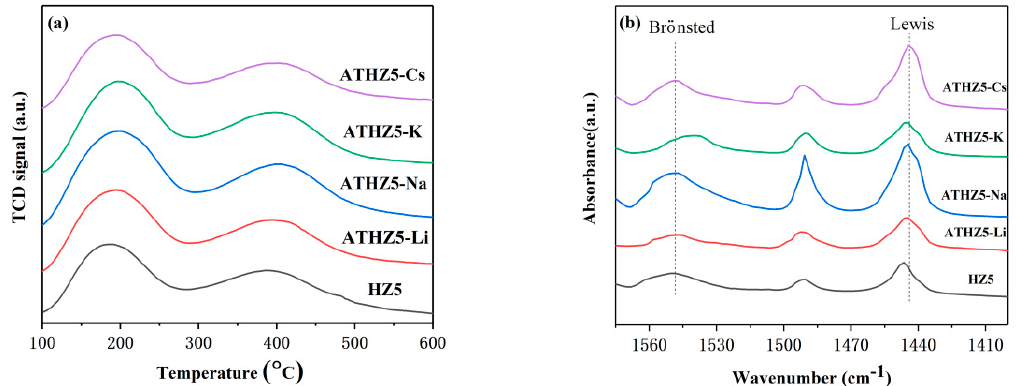
Table 2. Catalyst acidity results obtained by NH 3 -TPD and